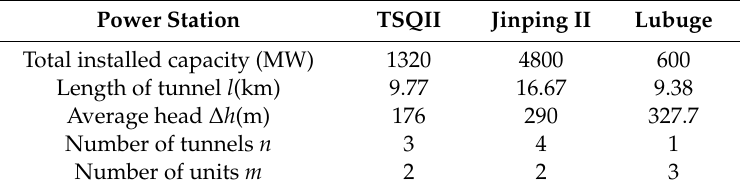
Figure 1. Sketch of hydropower plant with multiple turbines in one tunnel (HPMTT) with long diversion system. diversion system. Table 1. Unit parameters of typical hydropower Table 1. Unit parameters of typical hydropower plants.